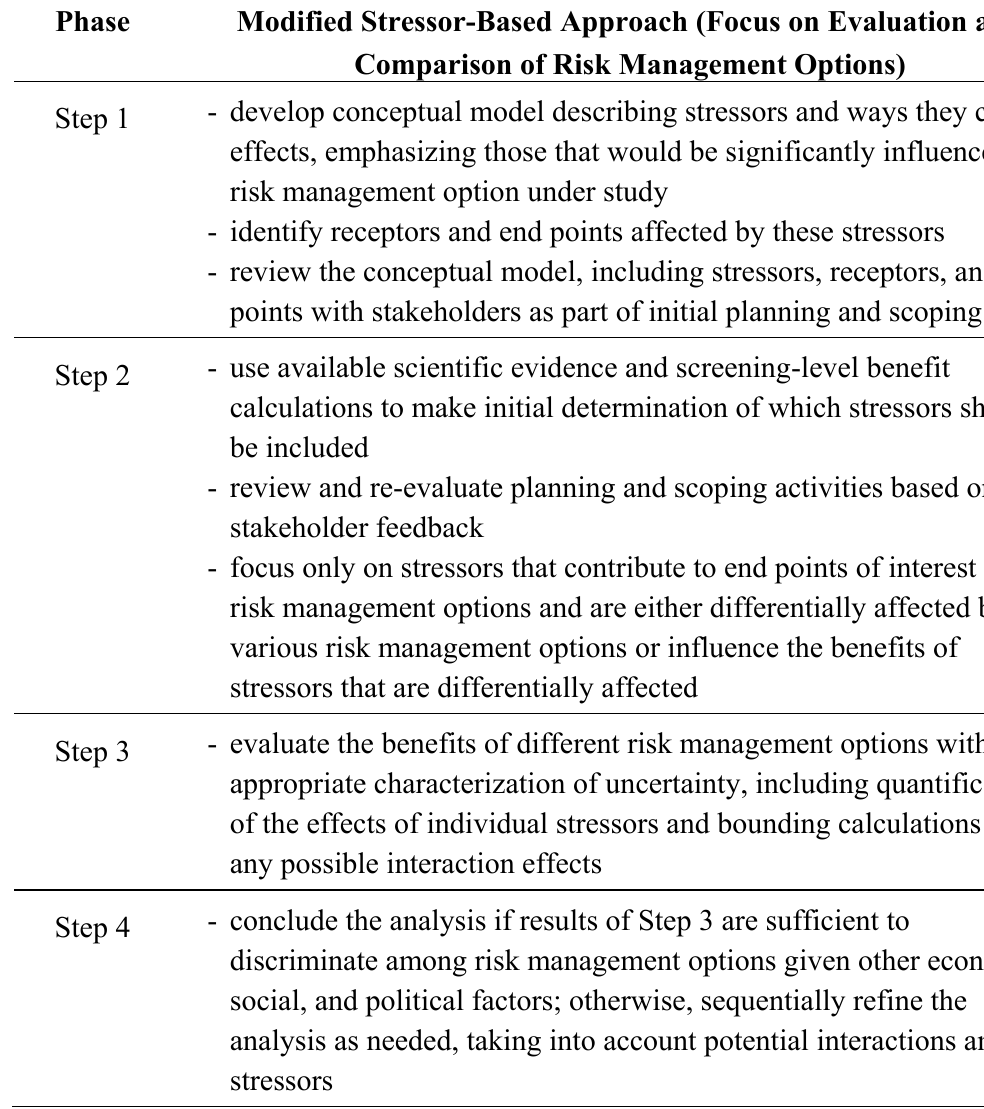
Table 6. The National Research Council’s Modified Version of the Stressor-Based Approach to Cumulative Risk Assessment, where the Primary Goal is to Discriminate among Risk Management Options